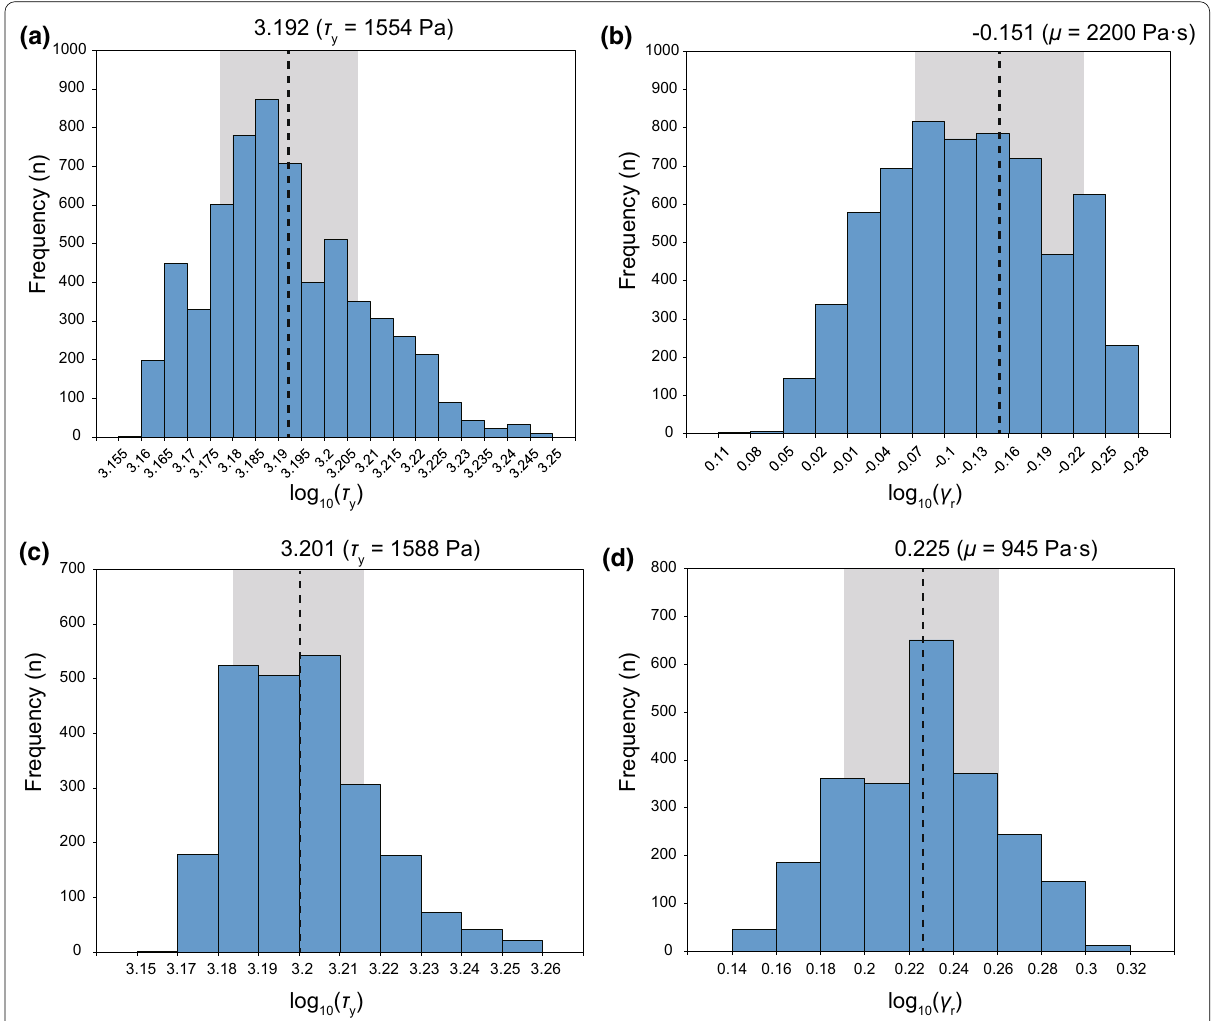
Fig. 5 Probability distributions of log 10 ( τ y ) and log 10 ( γ r ) obtained by the MCMC simulation. Mean values (dashed line) and standard deviations (grey shading) are shown for the high-viscosity ( a , b ) and low-viscosity ( c , d )